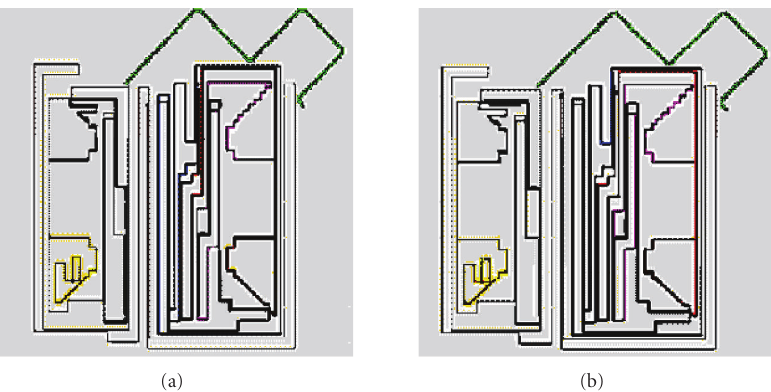
Figure 7: Snapshots of two runs of the same match: (a) unreliable communications, (b) reliable communications.